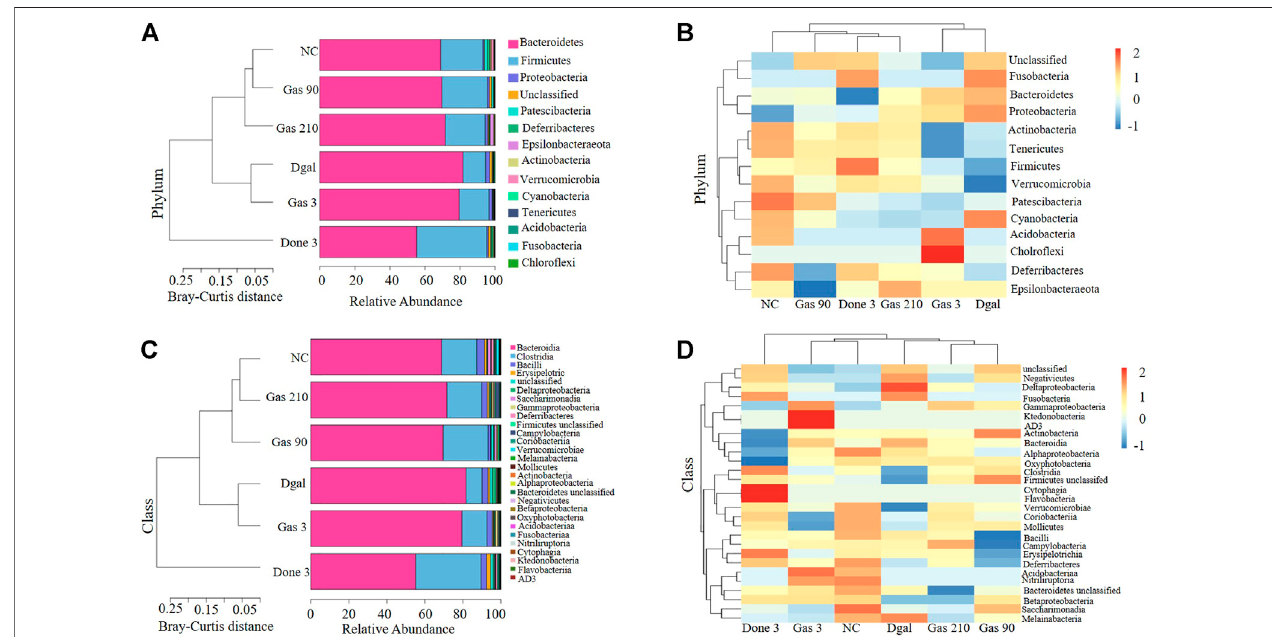
FIGURE 2 | Gas changes the gut microbiota composition in AD mice. (A) Bray – Curtis dissimilarity cluster analysis at the phylum level. (B) Heat map analysis at the phylum level. (C) Bray – Curtis dissimilarity cluster analysis at the class level. (D) Heat map analysis at the class level.